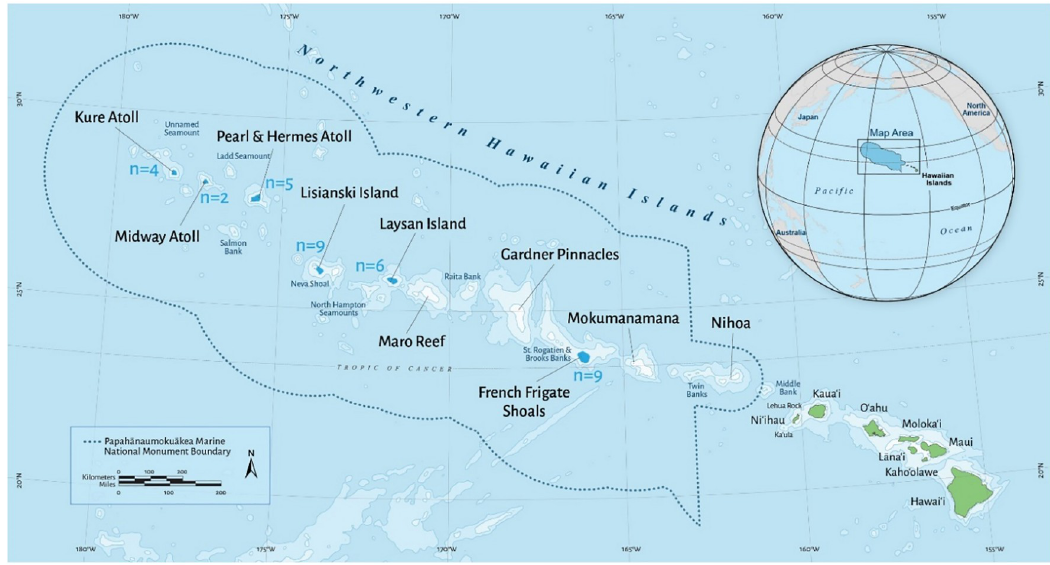
Fig 1. Map of survey sites. Papah ā naumoku ā kea Marine National Monument is located within the dotted lines and is ~ 1.5 million km 2 . In total, 35 paired surveys were conducted at 6 atolls—n values are the number of surveys by atoll.